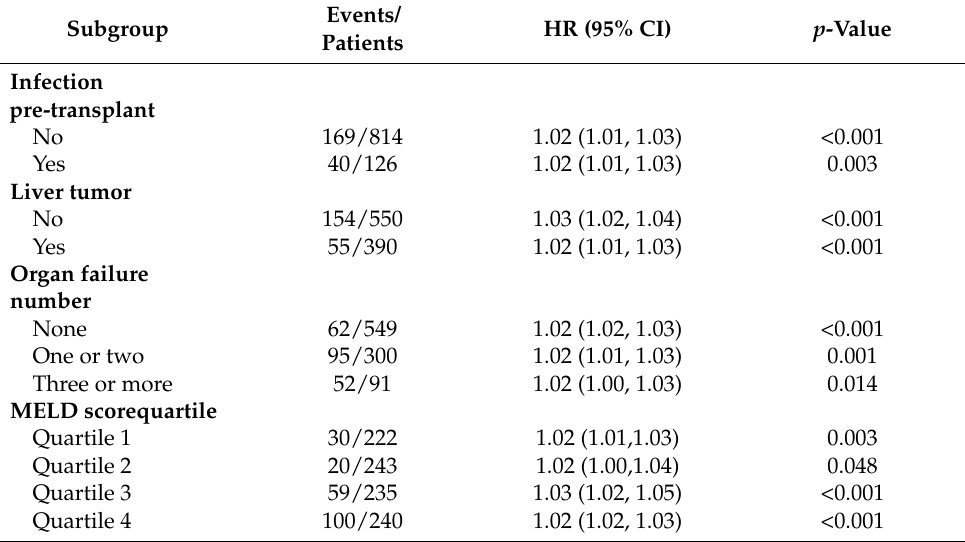
Table 3. Association between CRP and 30-day CSI according to subgroups.